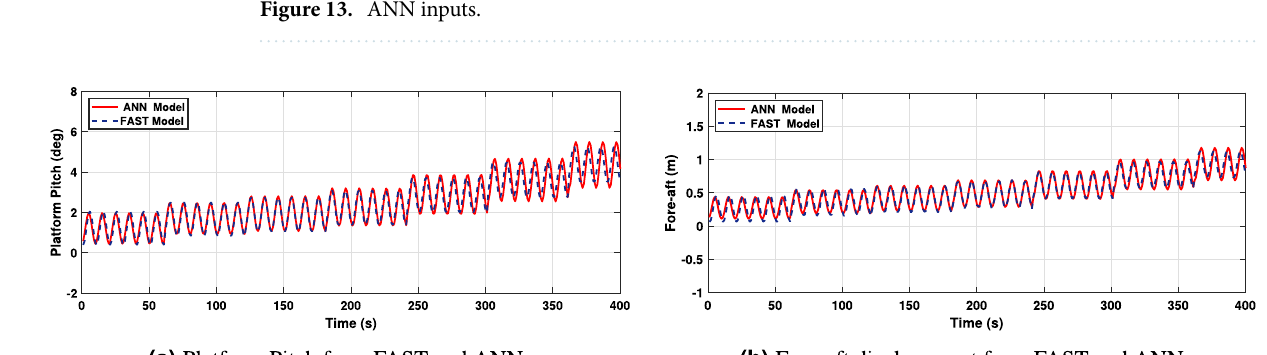
Figure 13. ANN inputs.